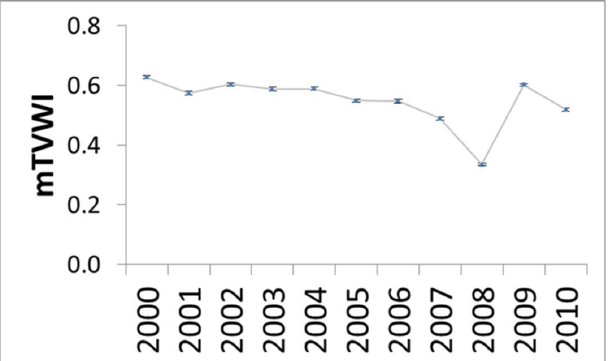
Figure 3. mean annual values of mTVWI (±SE) over the time period 2000–2010.